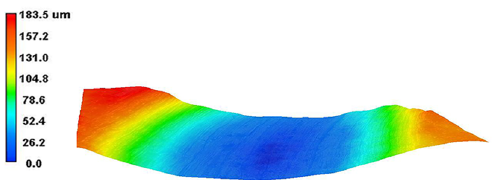
Figure 18. The 3D wear morphology of the TC18 substrate.